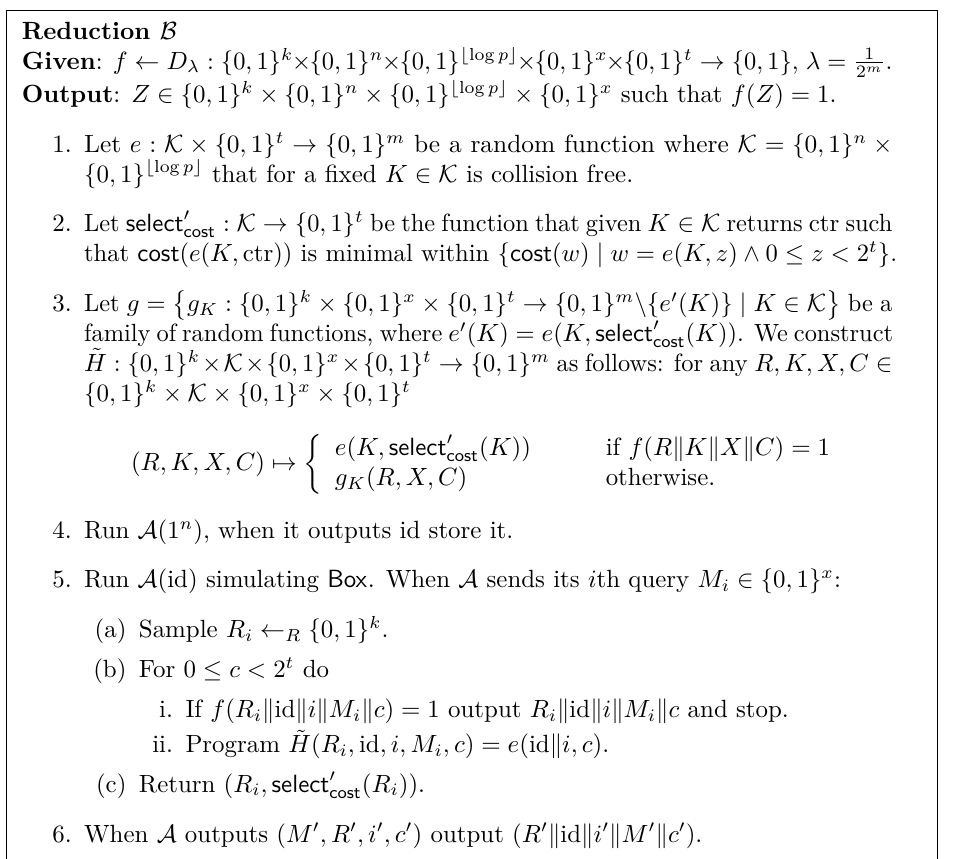
Figure 4.1: Reducing Avg-Search to cnM-eTCR